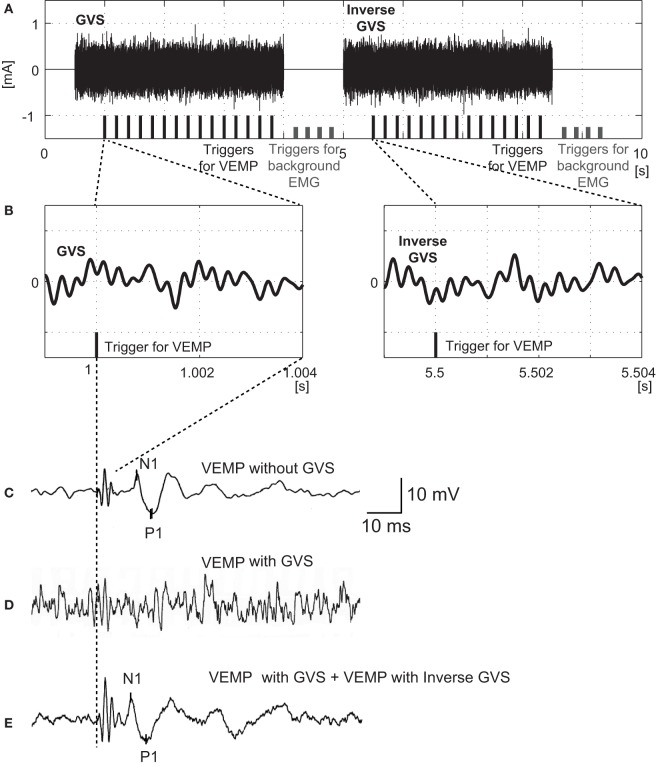
Protocols for application of noisy galvanic vestibular stimulation (GVS) and recording ocular vestibular-evoked myogenic potentials (oVEMPs) in response to bone-conducted vibration (BCV). (A) Schema of GVS and triggers for oVEMP measurement. During the early part of GVS (from 0.5 to 4 s) band noise between 1 and 4000 Hz with a flat spectrum was employed. In this example, the amplitude was 200 µA root mean square (RMS). During the later part of GVS (from 5 to 8.5 s), the waveform was inversed. The black bars at the bottom indicate the 15 triggers in each part for averaging oVEMPs. The short gray bars indicate the eight triggers used for averaging background EMG in the absence of BCV or GVS. (B) Magnified waveforms of GVS in the neighborhood of the oVEMP trigger. Note that the GVS in the later part is inversed. The 4 ms period after the trigger corresponds to the BCV stimulus duration for evoking oVEMPs. (C) oVEMP responses without GVS. (D) oVEMP responses after 15 triggers in the former part of noisy GVS (200 µA RMS). (E) Averaged oVEMP responses after 30 triggers (15 triggers in the early part and 15 triggers in the later part) of noisy GVS (200 µA RMS).